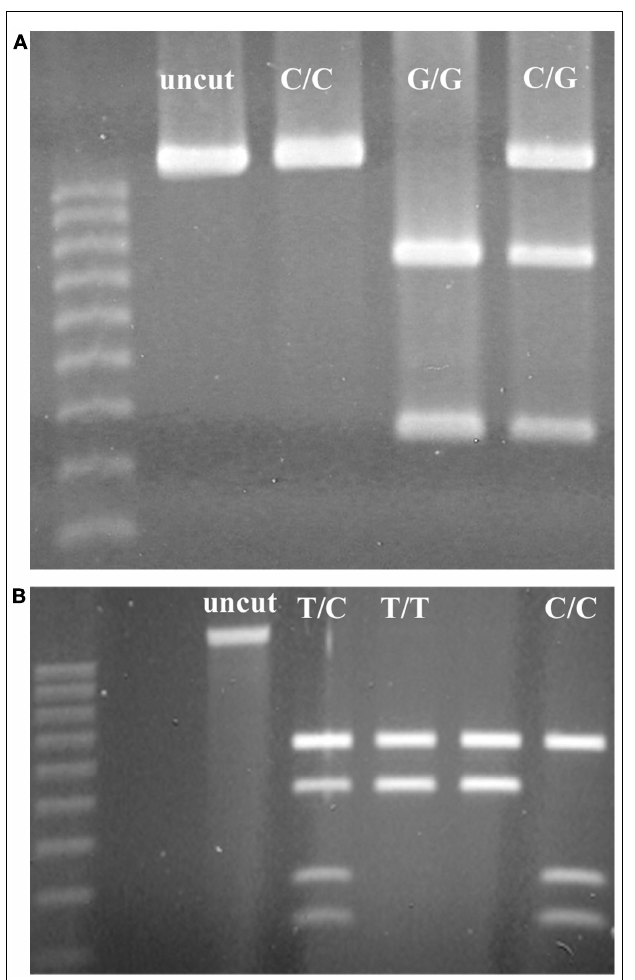
FIGURE 5 | Resolution of alleles of PCR-RFLP markers (A) Park9-Hae III (ss490571632) and (B) Park14-Eco RI (ss490571635) on 1.2% agarose gels.